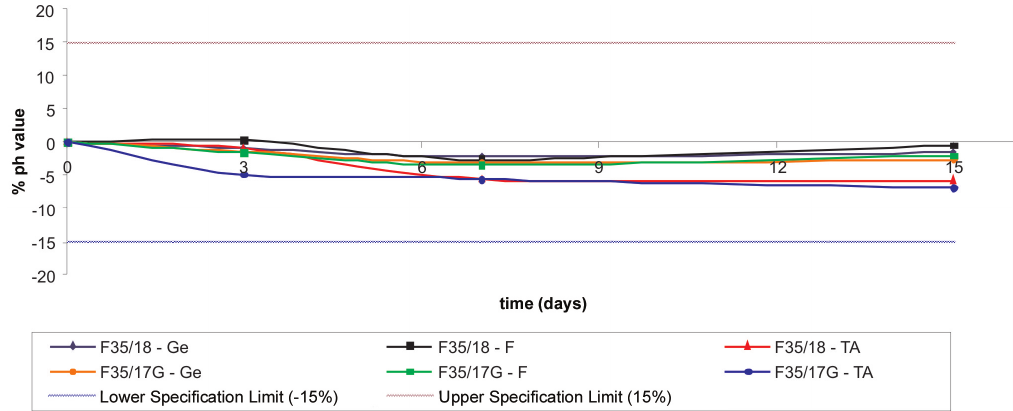
FIGURE 3 - Percentage variation of pH value for the test formulations F35/18 and F35/17G in the Refrigerator (Ge – 5.0 ± 1.0 °C), Freezer (F – -10.0 ± 1.0 °C) and Room Temperature (TA – 22.0 ± 2.0 °C) storage conditions in the Accelerated Stability